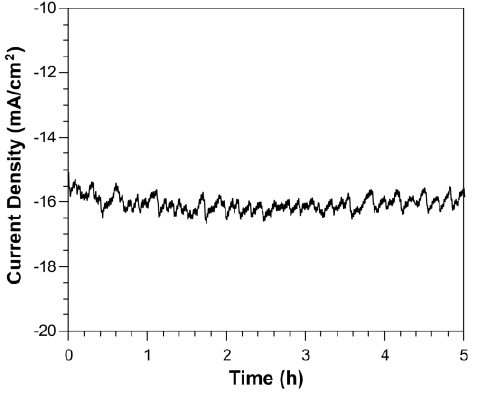
Figure 4. Current density measurement of SiNWs + {Ni 4 O 4 } clusters catalyst in 0.1 M H 2 SO 4 at a bias potential of −500 mV over 5 h.